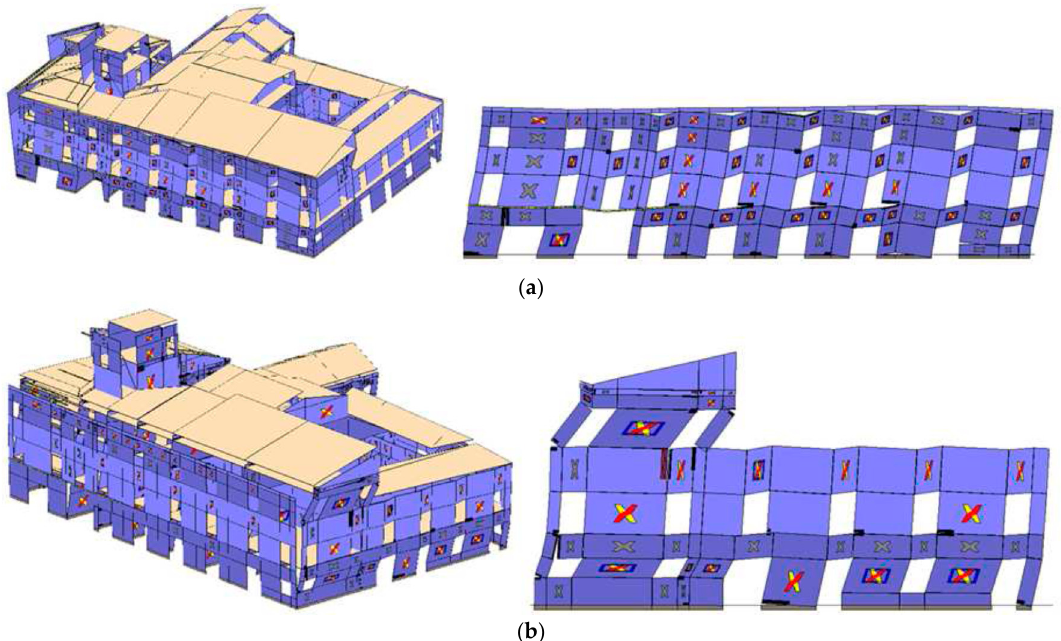
Figure 14. Collapse mechanisms: ( a ) longitudinal; and ( b ) transversal directions.